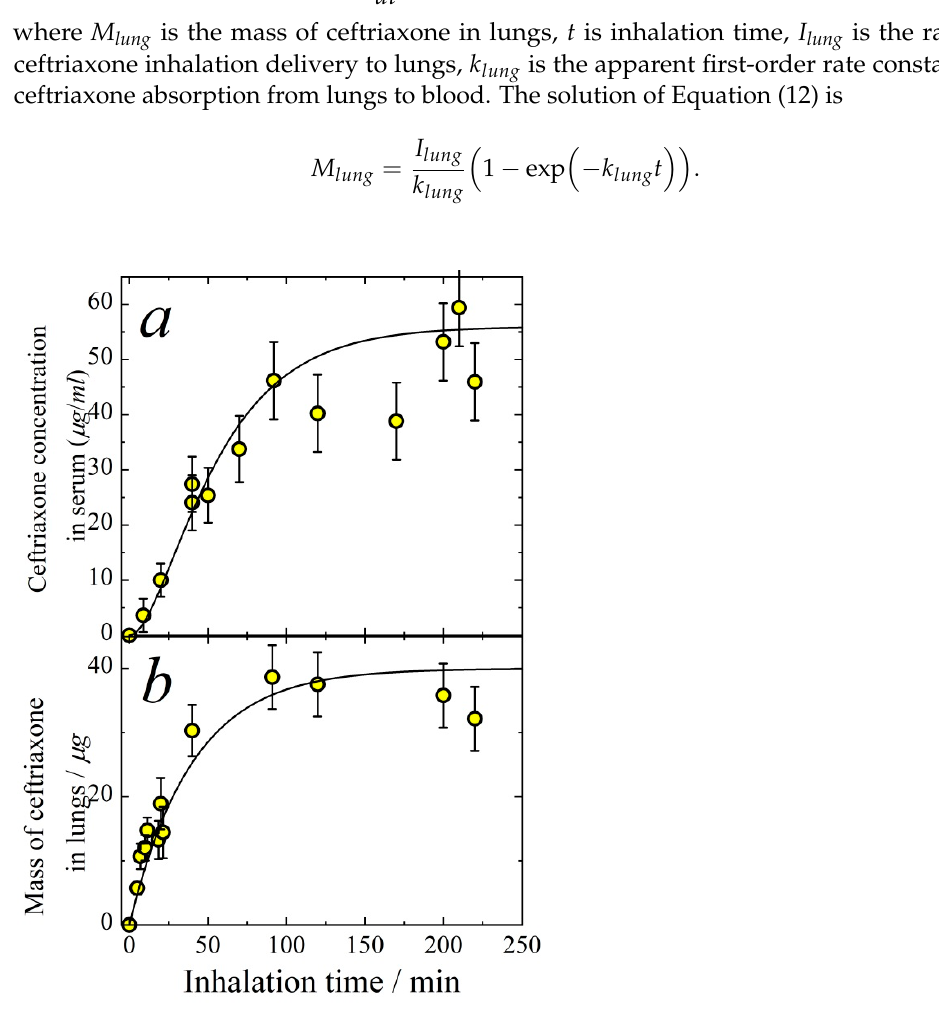
Figure 8. Ceftriaxone concentration in serum ( a ) and its mass in lungs ( b ) as a function of inhalation time. Aerosol mass concentration in inhalation chamber C A = 0.26 µ g/cm 3 , the mean particle diameter d = 1.4 µ m. Solid lines in panels ( a , b ) follow Equations (21) and (13), respectively.